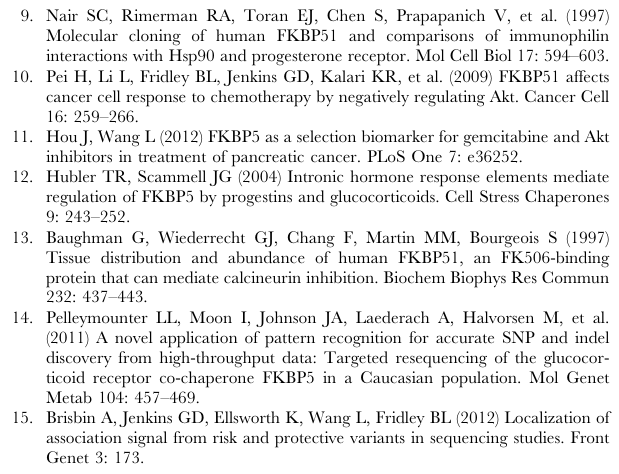
Figure S1 Functional characterization of FKBP5 allo- zymes. (A) Left panel. Quantitative Western blot analysis of FKBP5 Allozymes: WT, Thr(17)Ala, and Gln(383)Leu expression constructs in HEK293T cells performed with anti-Flag antibody; Right panel. qRT-PCR analysis of FKBP5 WT, Thr(17)Ala, and Gln(383)Leu mRNA expression levels in HEK293T cells. EV = empty vector. All values are representative of three independent experiments (mean + SEM.). (B) Cytotoxicity assays. Pancreatic cancer cell lines, Miapaca2 and Su86, were transfected with FKBP5 WT, Thr(17)Ala, and Gln(383)Leu expression constructs and treated with gemcitabine. Points show mean values for three independent experiments; error bars represent standard error of the mean (SEM). Figure S2 Linkage disequilibrium (LD) plot of selected FKBP5 SNPs. SNPs were selected based on the sliding window analysis (see Figure 1). The extent of linkage disequilibrium for the top SNPs from FKBP5 expression analysis and 5 SNPs binding to transcription factors (TF) from survival analysis, shown as pairwise R 2 - values, is depicted graphically. Figure S3 Correlation between FKBP5 and GR gene expression levels. (A) Relative FKBP5 and GR gene expression after FKBP5 knock-down in pancreatic cancer cells, 48 h after FKBP5 siRNA treatment. (B) Relative FKBP5 or GR gene expression (left or right panels, respectively) in Su86 or HupT3 cell lines (upper or lower panels, respectively) exposed to increased gemcitabine concentrations as compared to no treatment (NT). (C) Relative expression of GR 96 h after GR knock-down in Su86 cells ( left panel ). Relative FKBP5 expression after GR knock-down in Su86 cells treated with increasing concentration of gemcitabine over 72 h ( right panel ). Columns – mean average of three (or two) independent experiments ; Bars – SEM.